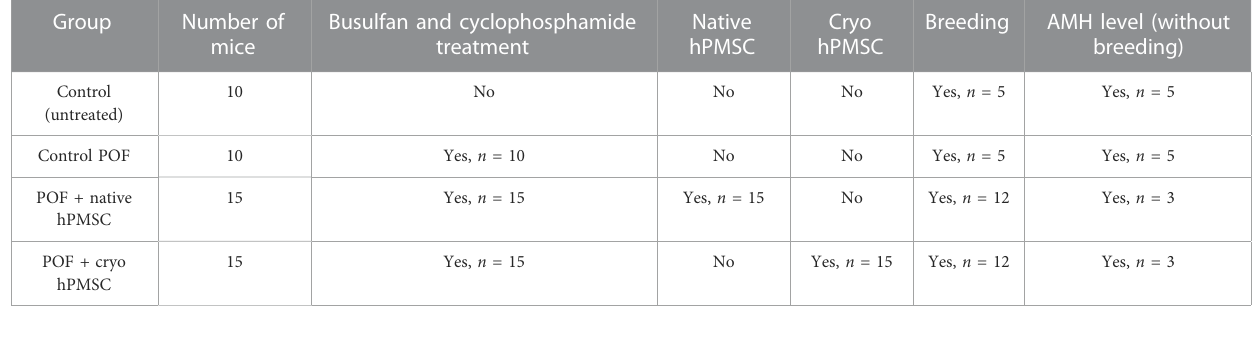
TABLE 1 Experimental design of the animal study.